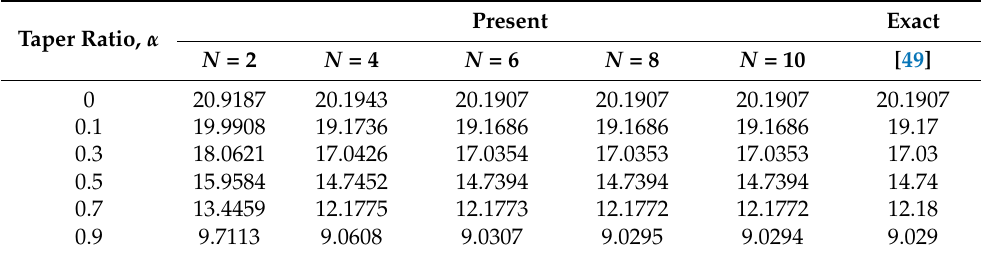
Table 2. Comparison and convergence of dimensionless critical buckling loads for homogeneous tapered propped cantilever microbeams ( l 0 = l 1 = l 2 = 0). Taper Ratio, α